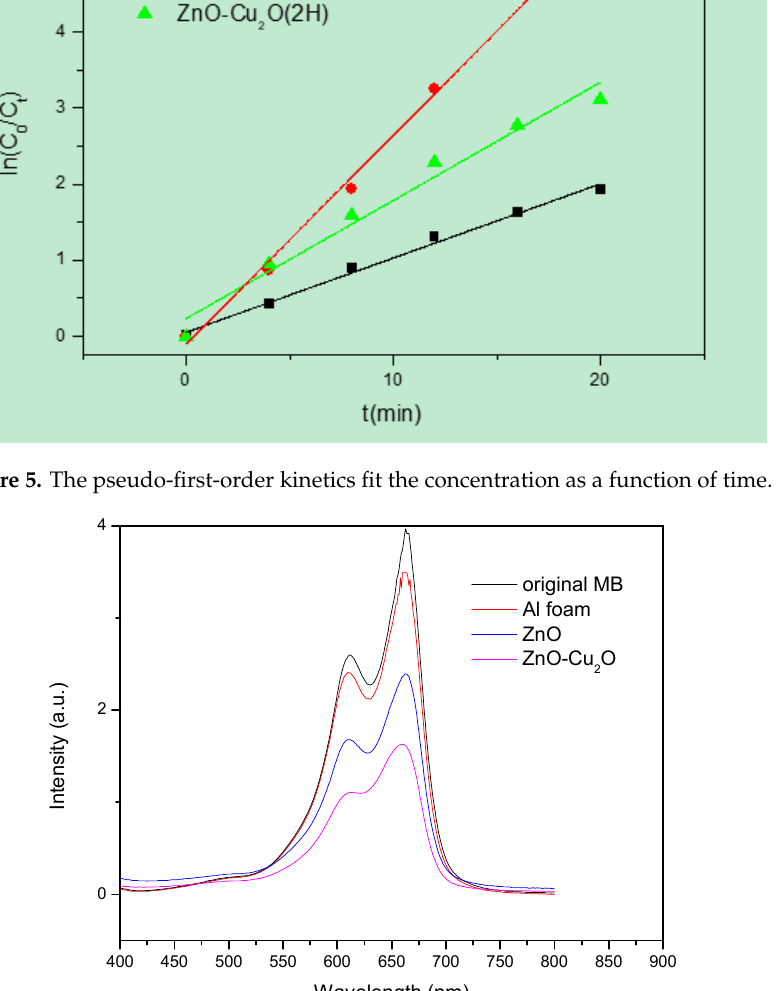
Figure 6. The decolorization of methylene blue (MB) with Al foam, ZnO, and ZnO-Cu 2 O as catalyst under ultrasonic irradiation.